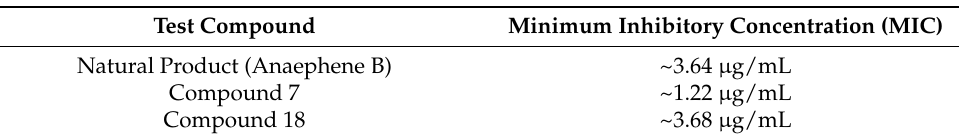
Figure 4. Dose-Dependent Effect of Natural Product Anaephene B on L. tarentolae . Additions at 100 h; Values are the mean and standard deviation for n = 4 replicates.